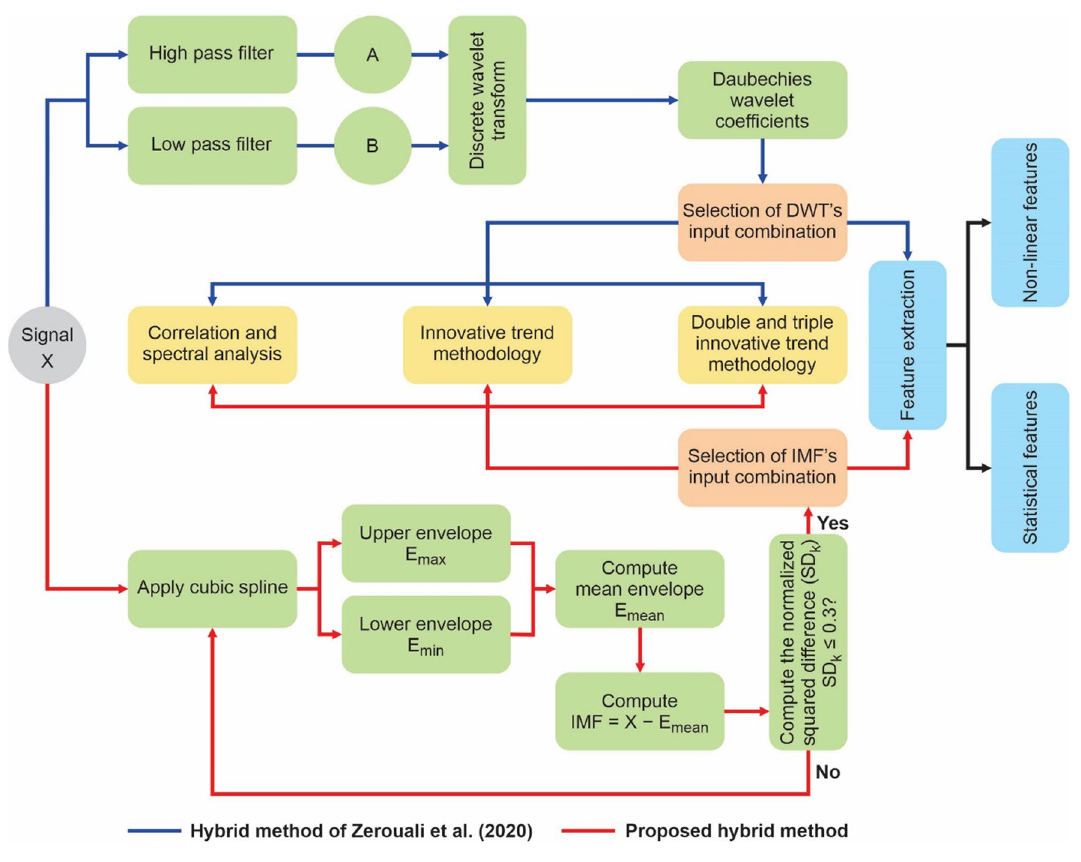
Fig. 3 Flowchart methodology proposed for this